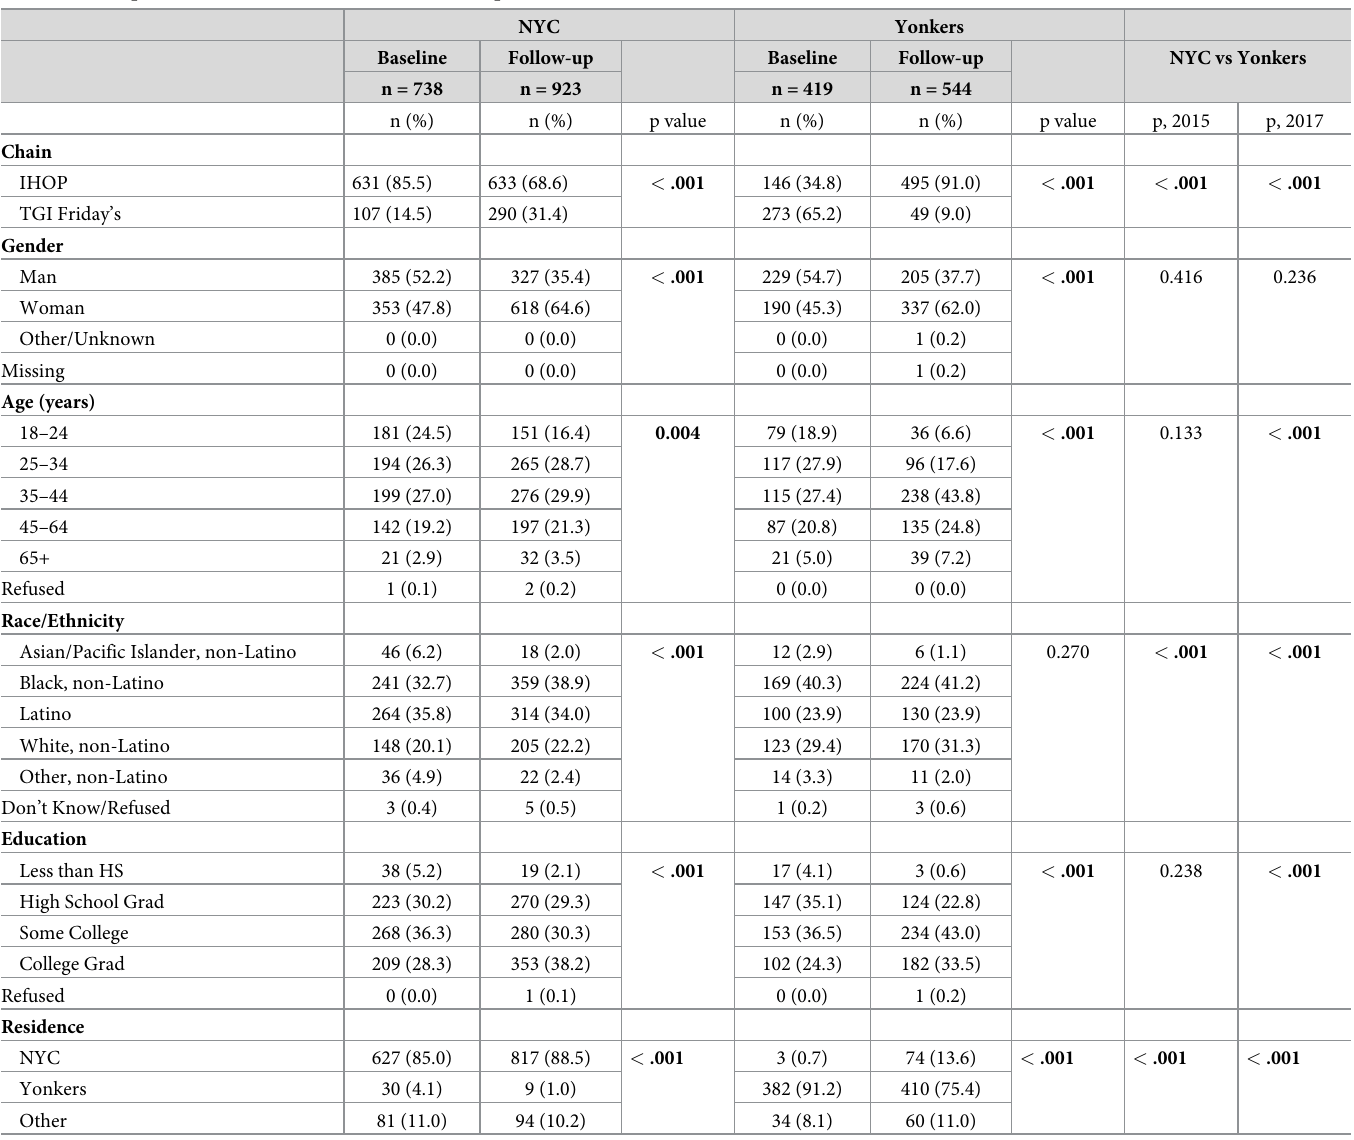
Table 1. Participant characteristics at baseline and follow-up, full-service